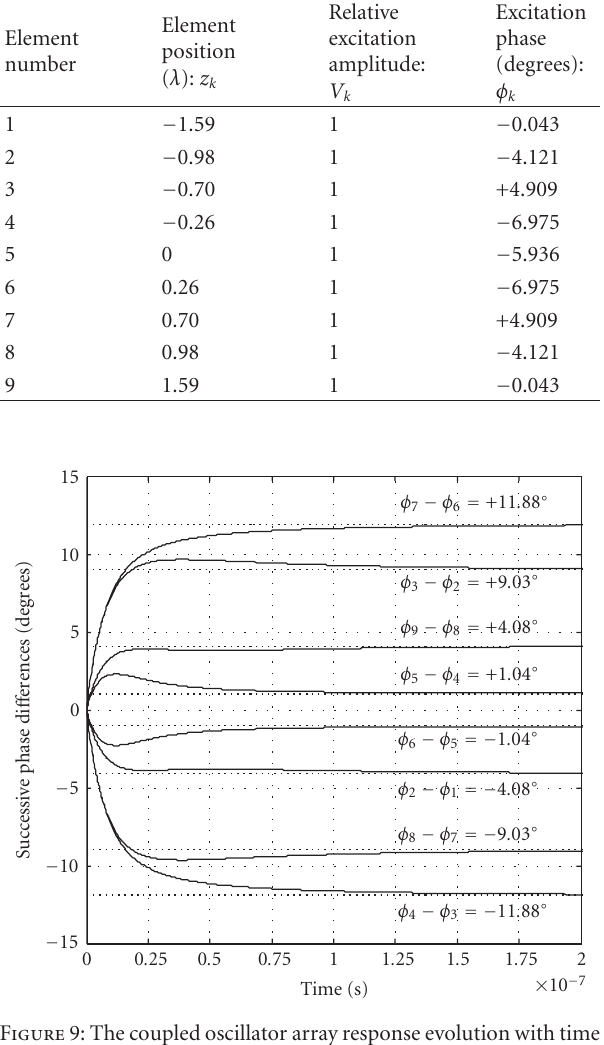
Table 6: Details on the constant amplitude design case.